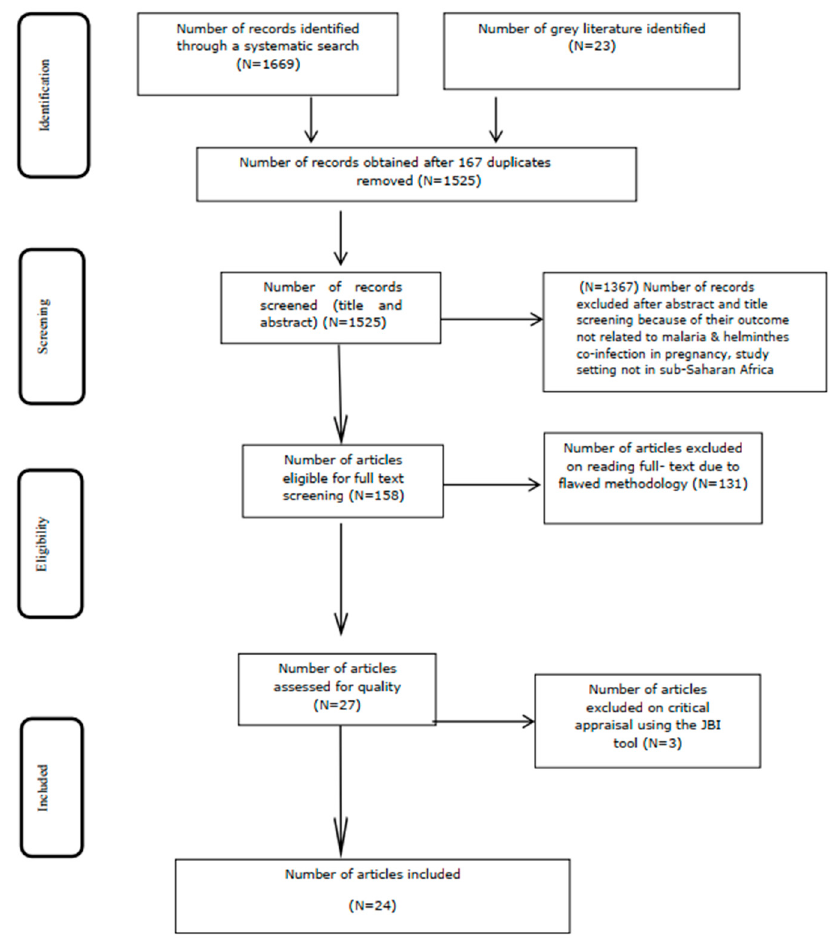
Figure 1. Flow diagram of the included studies. Moher, D. et al. Preferred Reporting Items for Systematic Reviews and Meta-Analyses: The PRISMA Statement. PLoS Medicine , 2009 , 6